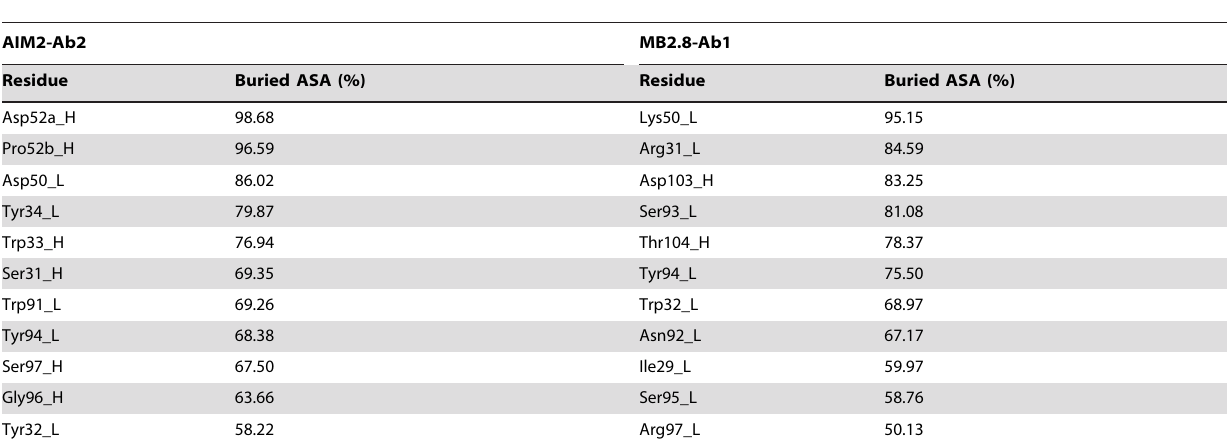
Table 5. M1-CDR residues that are more than 50% buried upon complex